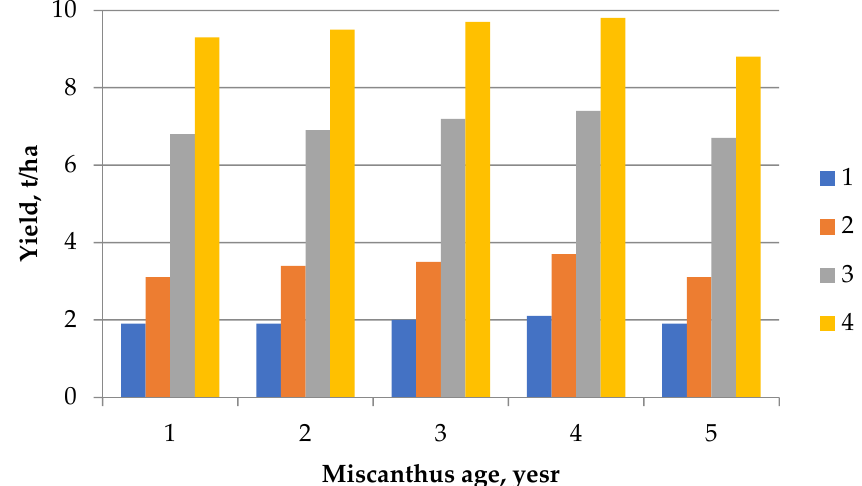
Figure 3. Influence of the nitrogen quantity (kg/ha) and irrigation on the miscanthus biomass yield: 1–100 kg/ha; 2–100 kg/ha and irrigation; 3–200 kg/ha; 4–200 kg/ha and irrigation (the figure is based on the data from [56,57]).